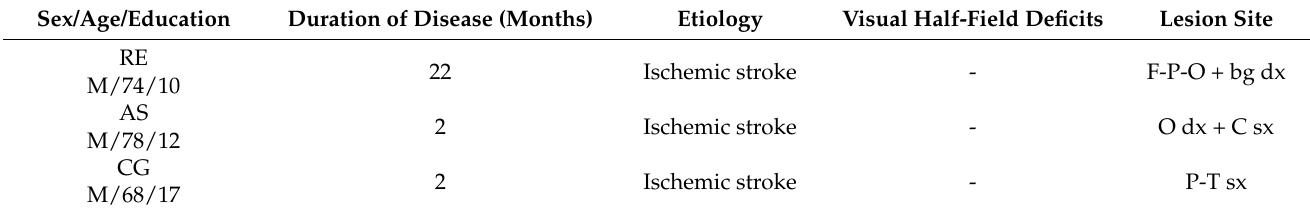
Table 1. Demographic and neurological features for the three patients selected. Lesions: F, frontal lobe; P, parietal lobe; T, temporal lobe; O, occipital lobe; C, cerebellum. Gender: M/F, male/female. Sex/Age/Education